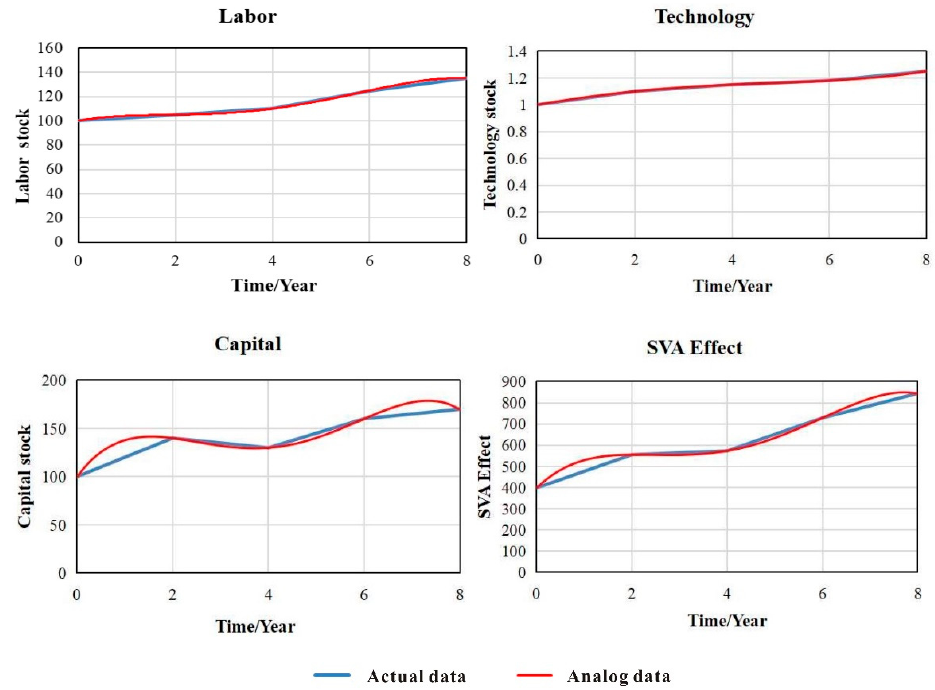
Figure 6. Structural inspection results. The Y axis has no units. Y axis indicates the degree, which is a unitless dimension.